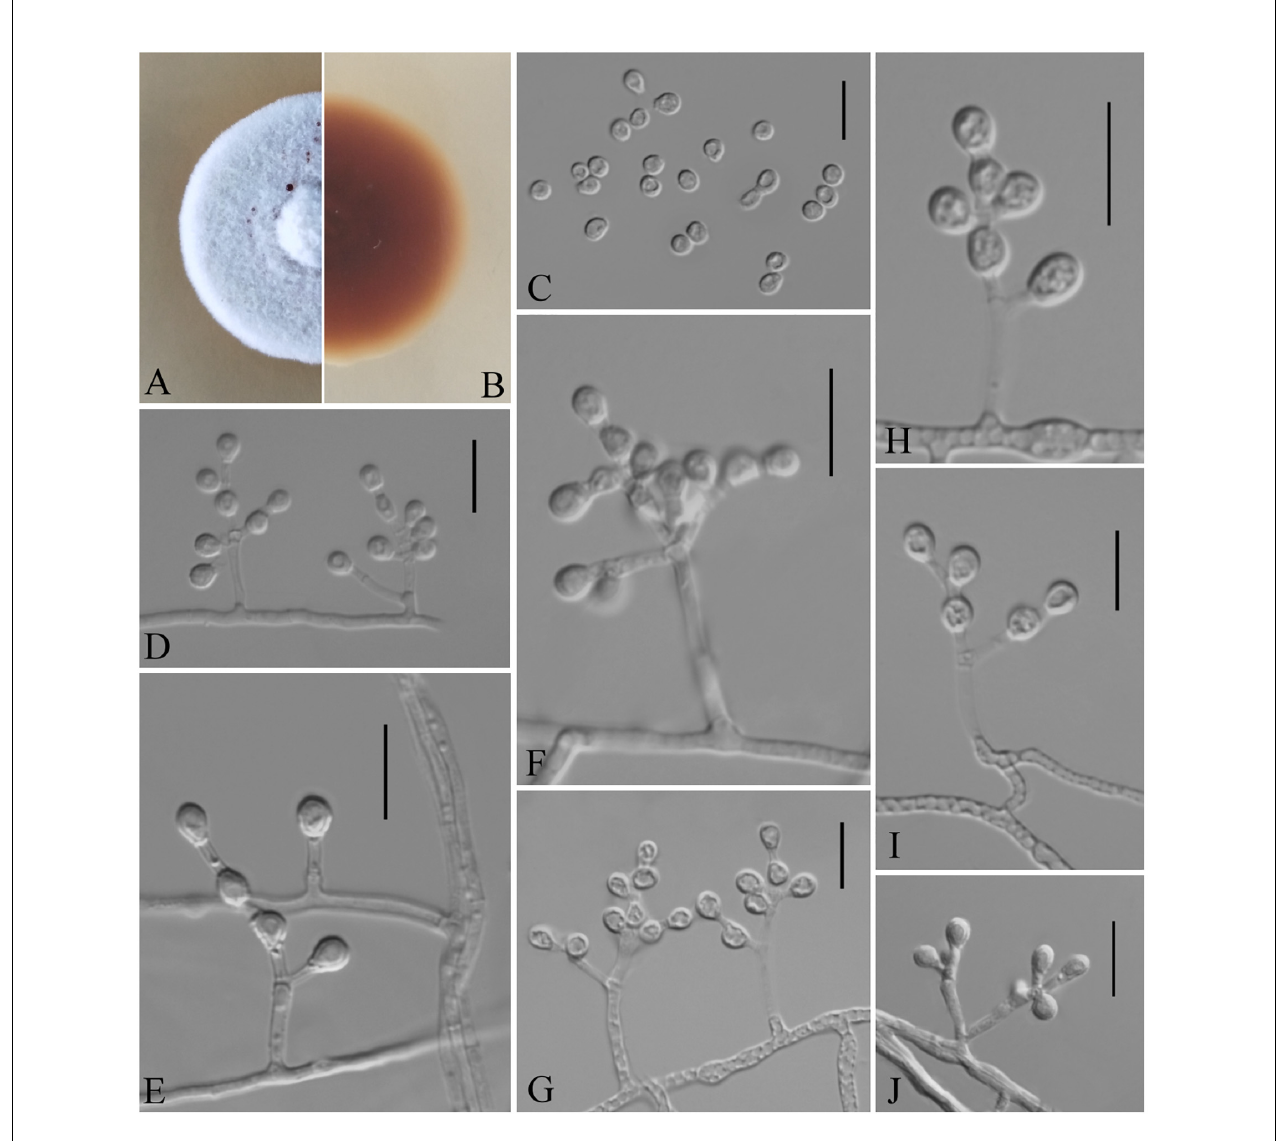
FIGURE 5 | Pseudogymnoascus shaanxiensis (from ex-holotype GZUIFR 173.1). (A,B) The front and reverse of a P. shaanxiensis colony on PDA after 14 days at 25 ◦ C. (C) Conidia. (D–J) Conidiophores and conidia. Scale bars = 10 µ m.